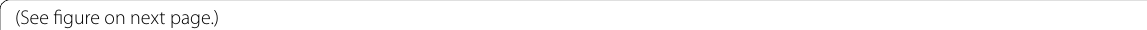
figure on next Fig. 2 Reactivity of different antibody subclasses against birch pollen proteins and therapy-related changes. Immunoblot experiments with birch pollen extract and sera of birch pollen AIT patients (P1–5) collected at three time points of immunotherapy (T0, T1, and T2). Bet v 1 is framed in black; NA, non-allergic serum; NBA, non-birch allergic serum; BC, buffer